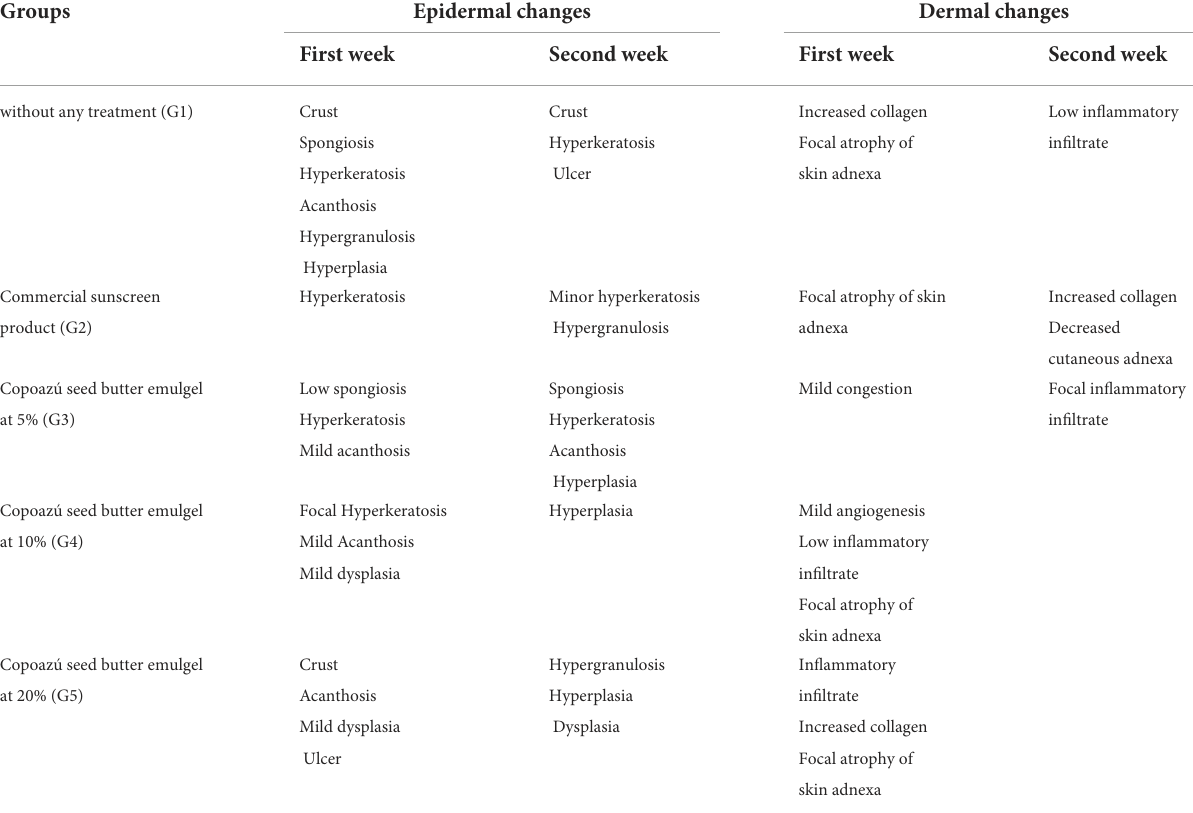
TABLE 3 Microscopic analysis of the epidermis and dermis of the mice skin exposed to UVB radiation.